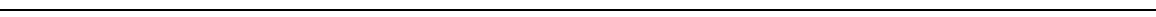
Fig. 3 HSCs cultured in vitro lose their stemness upon cell division and acquire an MPP-like gene expression pro fi le. a Flow cytometry plots showing the percentage of cells in the G 0 , G 1 , or S/G 2 /M phases of the cell cycle based on DNA content (Hoechst) and Ki67 expression for HSCs cultured for 9, 24, 48, or 72 h. b Percentage of cells in G0 ( red ), G1 ( gray ) or S/G2/M ( white ) after 9, 24, 48, or 72 h in culture. c Percentage of cells having undergone no division ( white ), one division ( gray ), or more than one division ( blue ) in function of time. d Combined heat-map of Ct values for 24 genes from freshly isolated HSCs and cultured HSCs after hierarchical clustering (Number of single cells for HSC n = 28, 1 div n = 52, 2 div n = 19, total n = 99). Colored squares indicate the population of origin for each single cell ( red , freshly isolated HSC; mauve , one division in culture; purple , two divisions in culture). e Single-gene expression values of cultured HSCs compared to freshly isolated HSCs after principal component analysis (PCA). Individual cells are projected on principal components PC1 and PC2 conserved as in Fig. 1b. Colored points belong to the indicated populations ( red , freshly isolated HSC; mauve , one division in culture; purple , two divisions in culture). Assuming Gaussian distributions, ellipses show the 75% regions of highest density. f PC1 and PC2 coef fi cients for all single cells are shown on boxplots. Center lines indicate mean. Box limits indicate twenty- fi fth percentile and seventy- fi fth percentile. Whiskers indicate extreme data points excluding outliers. Crosses indicate outliers. See also Supplementary Figs. 3 and